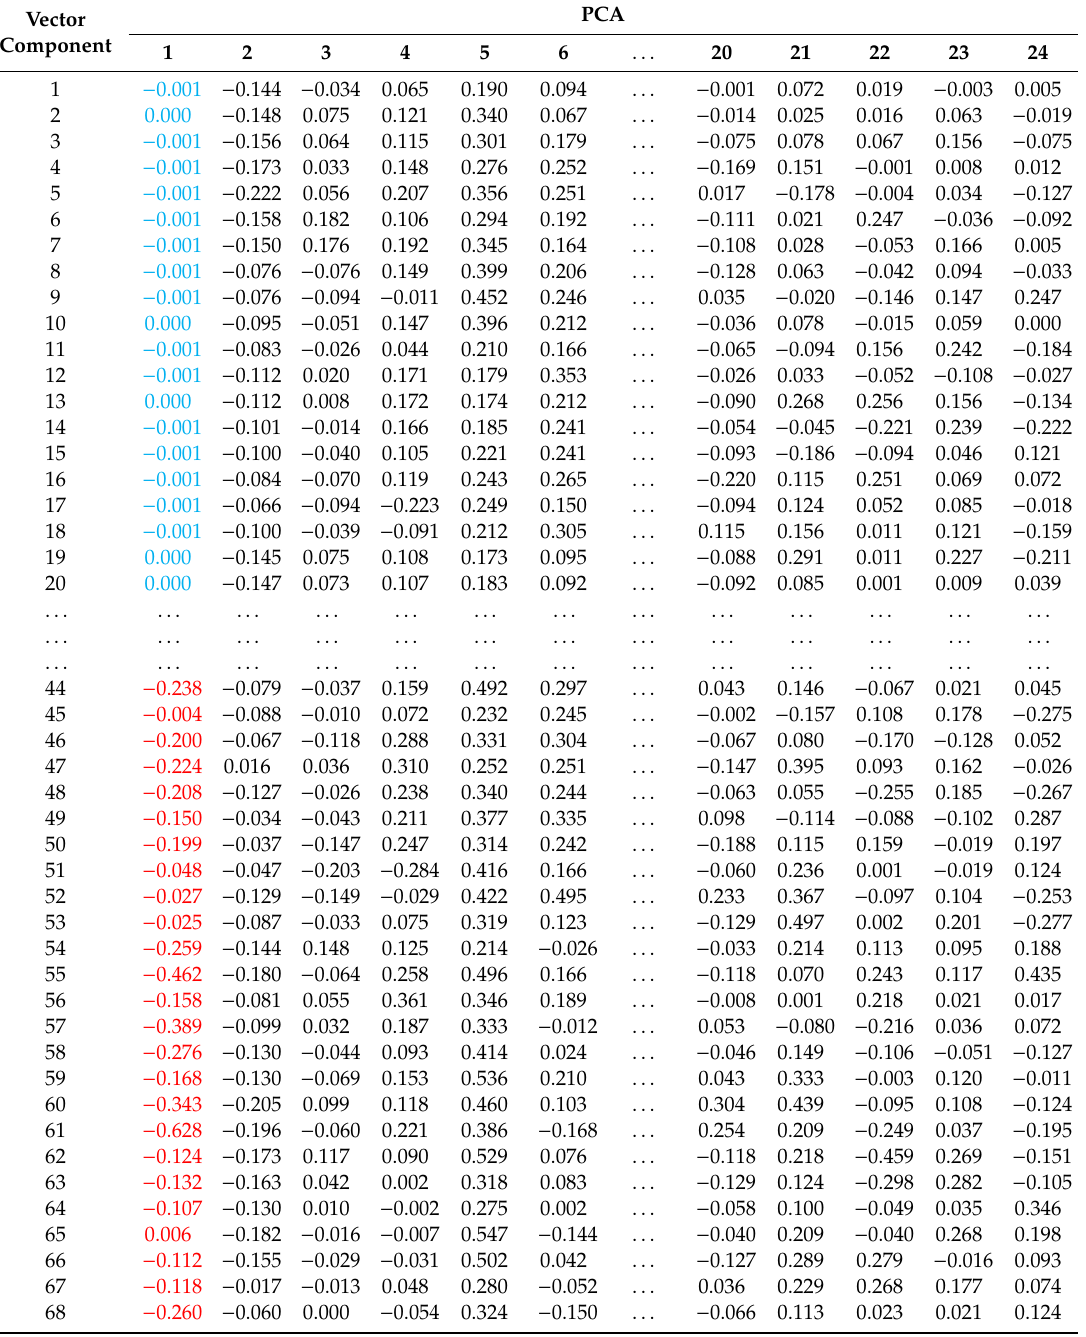
Table 1. Principal Component Analysis (PCA) vector values